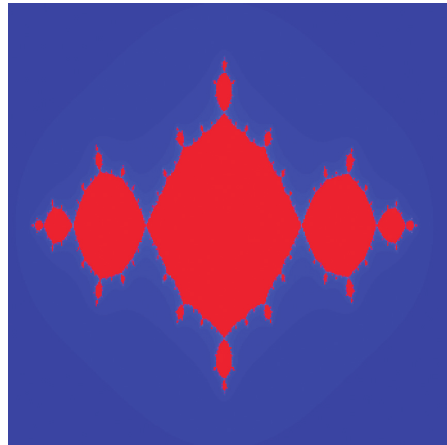
Figure 5: Quadratic Julia set in � 3 , a � 10, a, m � 0 . 5 , Figure 14: p � 2, a 1 2 b � 0 . 9 , s � 0 . 8, A � [− 0 . 17 , 0 . 05 ] × [− 0 . 07 , 0 . 07 ] . � 2 , a � 100, a � 0 . 5 , b � 0 . 9 , Figure 15: p � 2, a 1 2 s � 0 . 8 , m � 0 . 9, A � [− 0 . 0081 , 0 . 0005 ] × [− 0 . 001 , 0 . 001 ] . � 100 , a � 1, a, b � 0 . 5 , s � 0 . 9 , Figure 16: p � 2, a 1 2 m � 0 . 7, A � [− 4200 , 501 ] × [− 1201 , 1201 ] . � 1 , a � ( a − 1 ) , a, b � 0 . 5 , Figure 17: p � 2, a 1 2 0 s � 0 . 9 , m � 0 . 7, A � [− 0 . 15 , 0 . 7 ] × [− 0 . 4 , 0 . 4 ] . � 2/3 , a � 1, a, b, s, m � 0 . 9, Figure 18: p � 2, a 1 2 A � [− 0 . 001 , 0 . 002 ] × [− 0 . 001 , 0 . 001 ] .